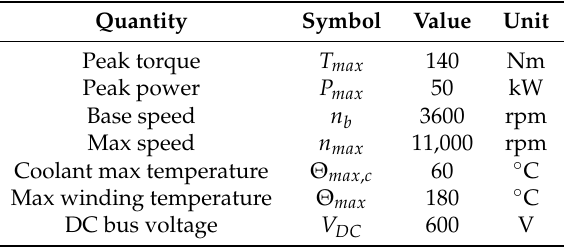
Table 2. Input design specifications for the electric